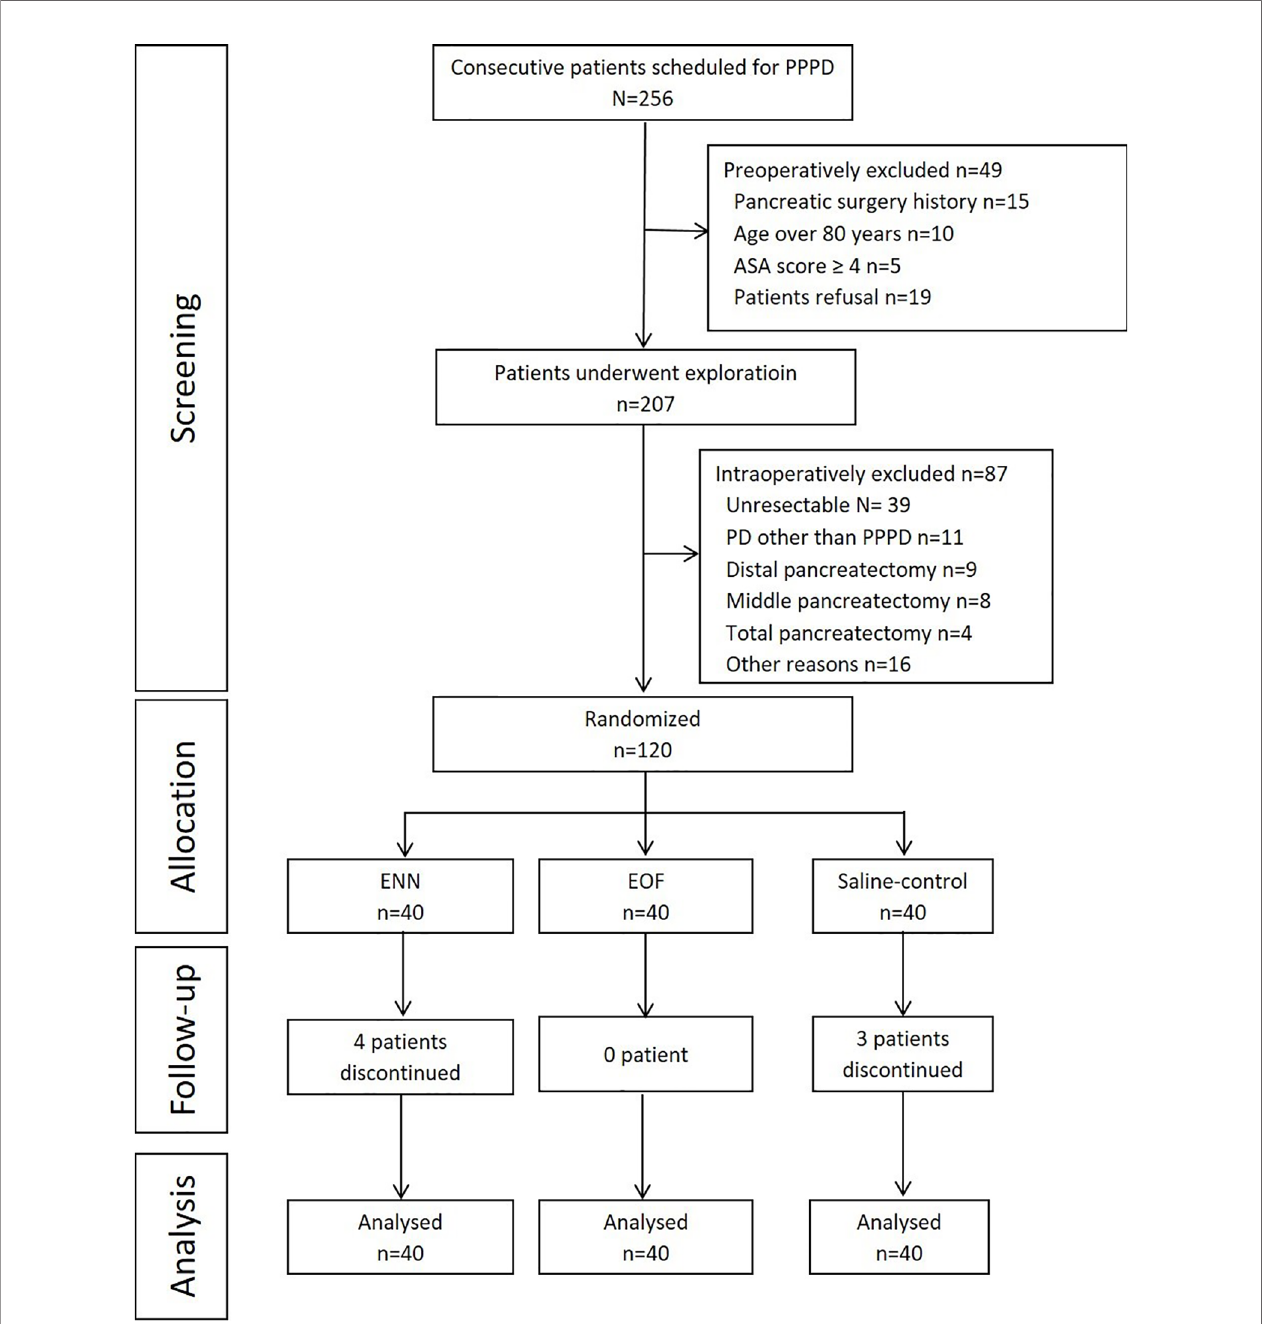
FIGURE 1 | Flowchart of the study. PPPD, pylorus-preserving pancreaticoduodenectomy; PD, pancreaticoduodenectomy; ASA, American Society of Anesthesiologists; EOF, early oral feeding; ENN, early nasojejunal